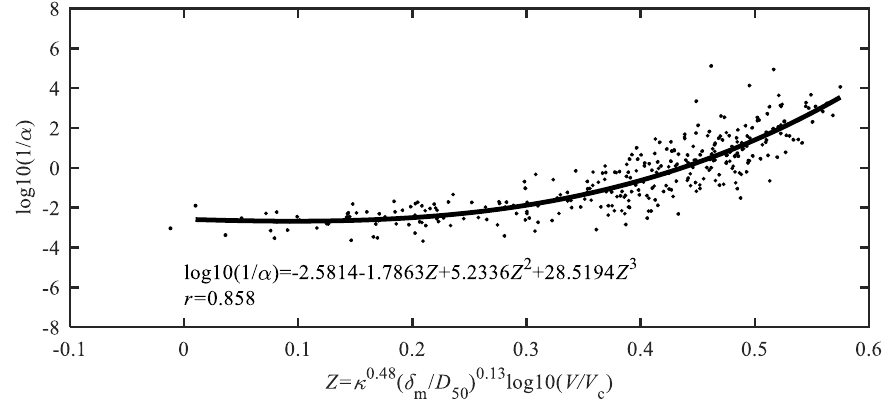
(cid:17) , and the c